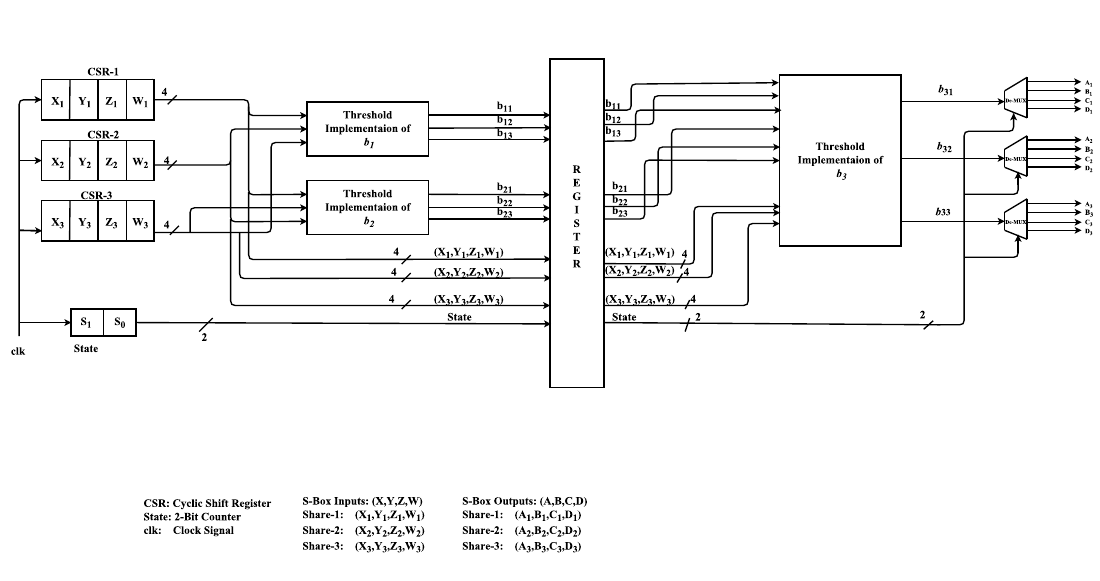
Figure 4.1: Architecture for TI circuits corresponding to CA-based